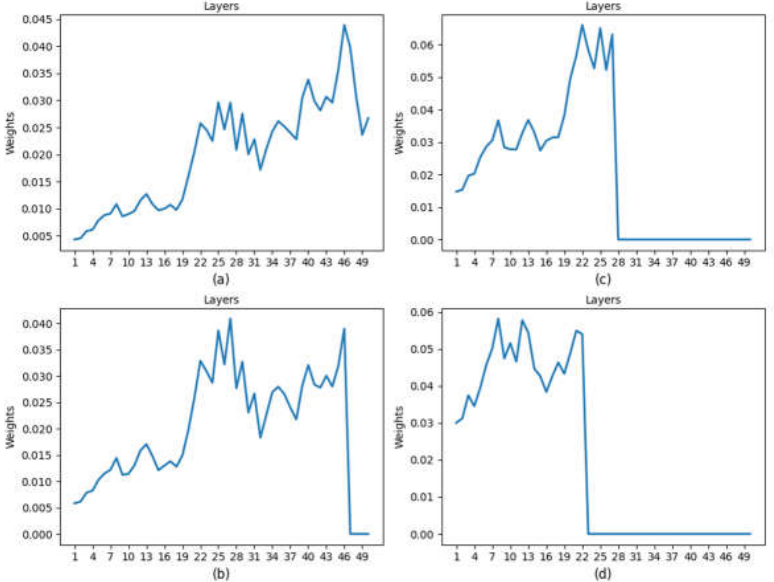
Figure 9. Layer relevance weights learned by the proposed class-dependent ANNA on MNIST dataset after training the model using: ( a ) 1 batch; ( b ) 4 batches; ( c ) 6 batches; ( d ) 15 batches.